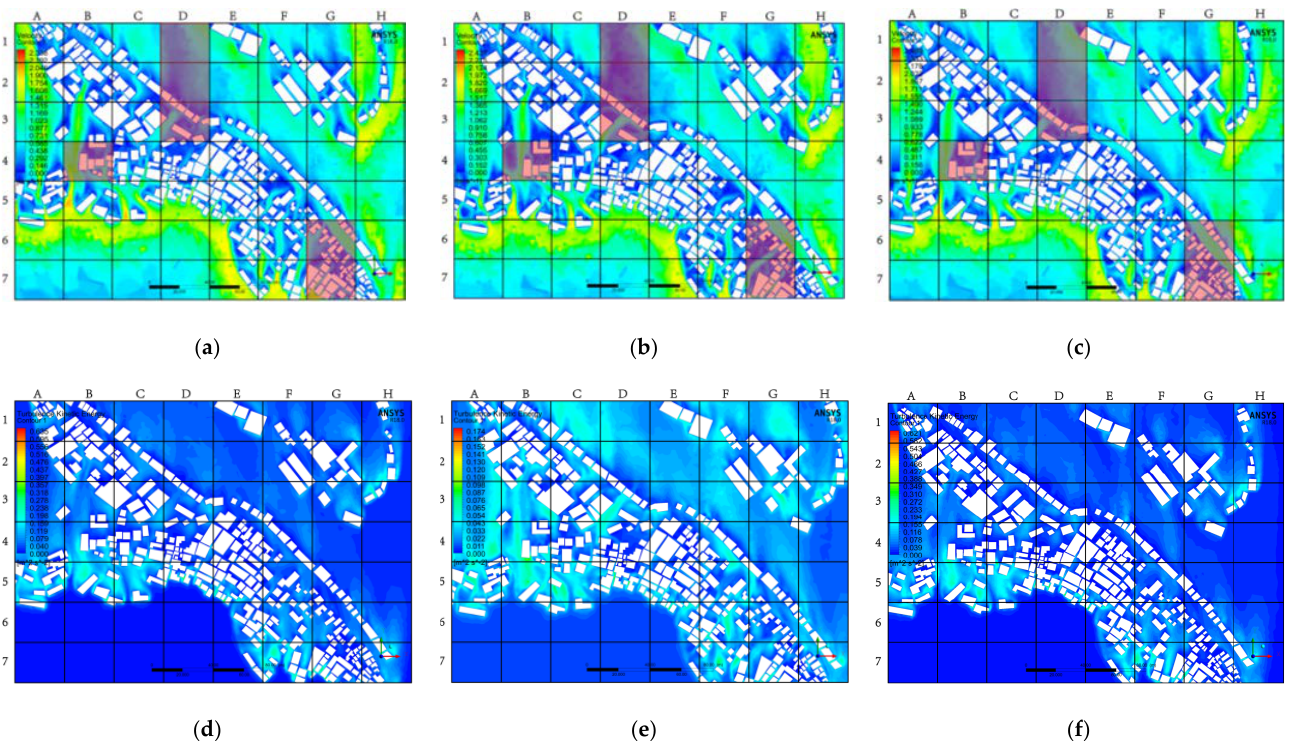
Figure 13. Distribution of wind environment and turbulence intensity of the whole village. ( a ) The overall village wind environment simulated by SKE. ( b ) The overall village wind environment simulated by RNG. ( c ) The overall village wind environment simulated by RKE. ( d ) Turbulence intensity of the whole village simulated by SKE. ( e ) Turbulence intensity of the whole village simulated by RNG. ( f ) Turbulence intensity of the whole village simulated by